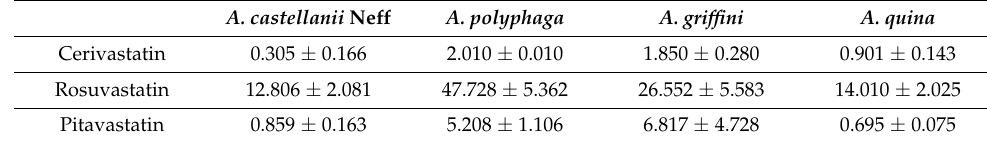
Table 2. IC 90 of three different statins against Acanthamoeba spp. ( µ M).